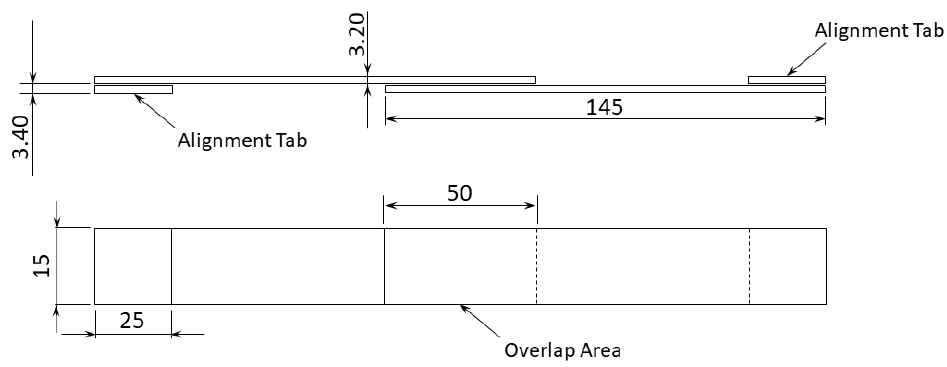
Figure 1. SLJ specimen geometry, in mm.